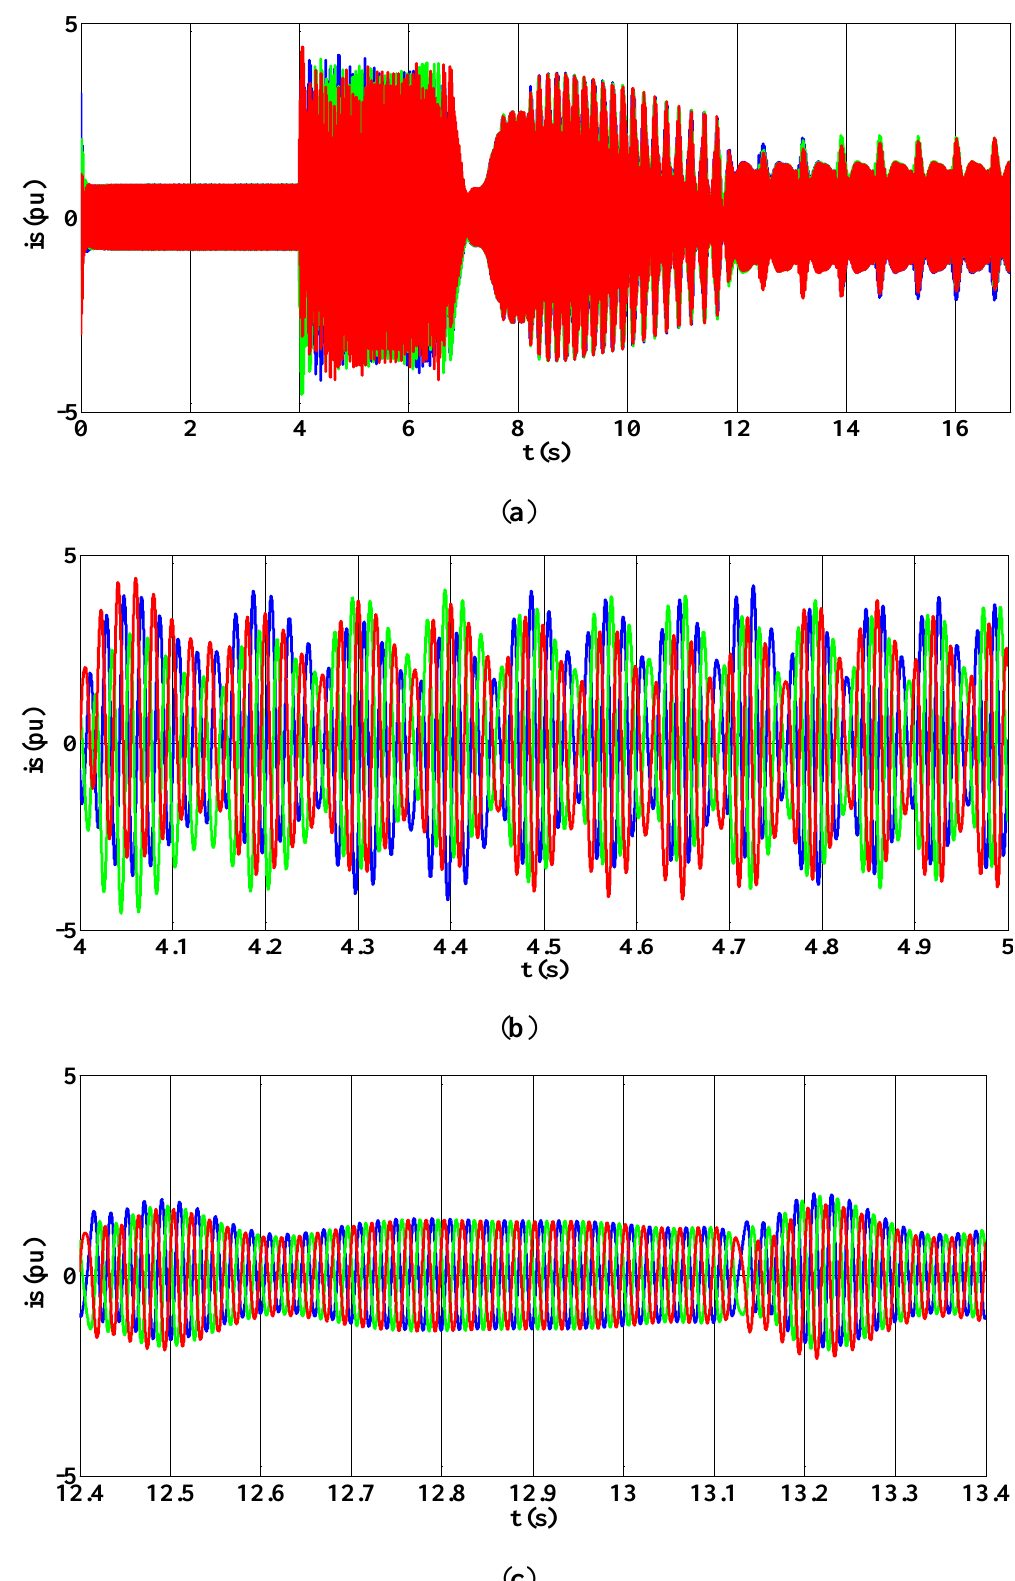
Figure 12. ( a ) Stator currents (short-circuit happens at t = 4 s), ( b ) zoom of (a) immediately after fault; ( c ) zoom of (a) after system